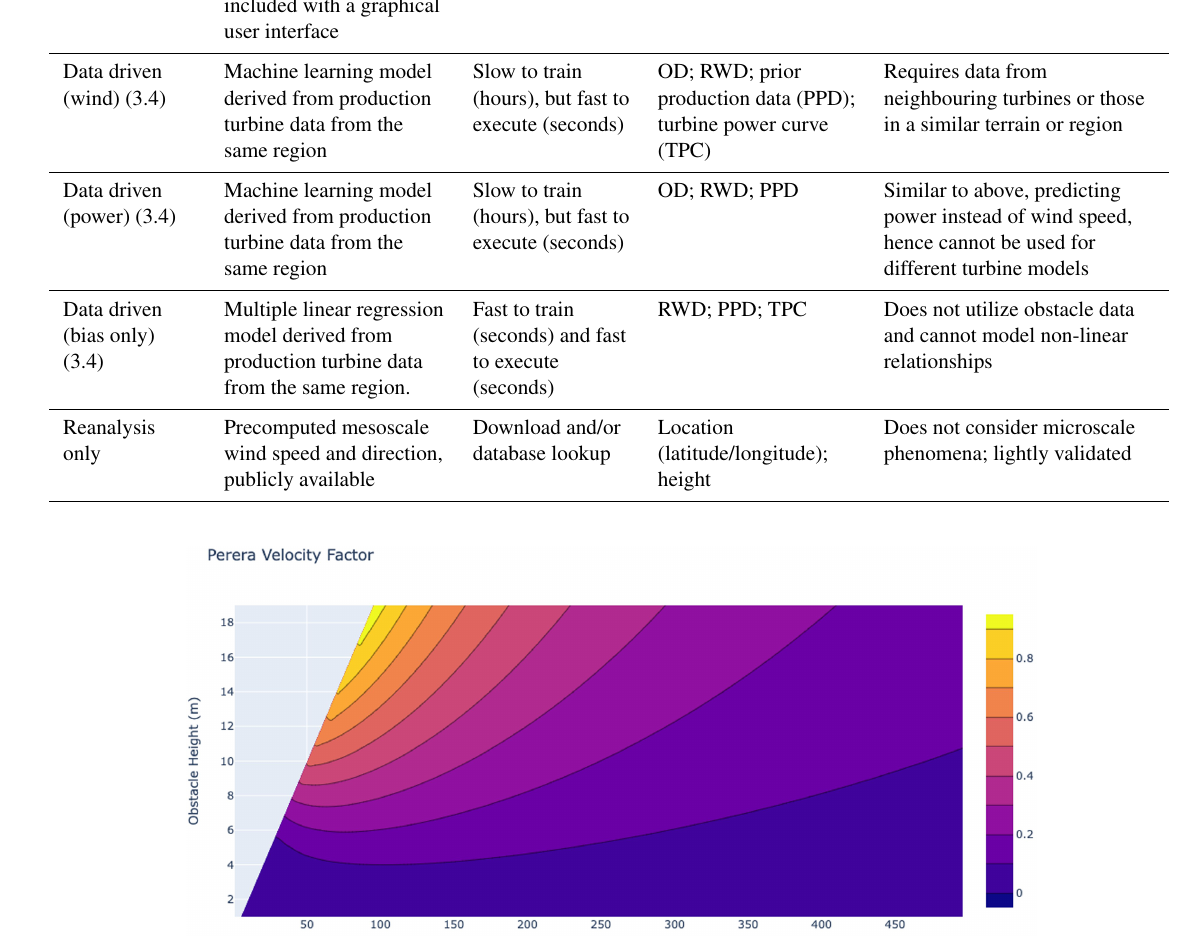
Figure 4. Velocity deficit factor prescribed by the Perera model for different combinations of obstacle heights and distances downwind. The missing data in the triangular section at left are those points within 5h where the model cannot make an accurate estimate.